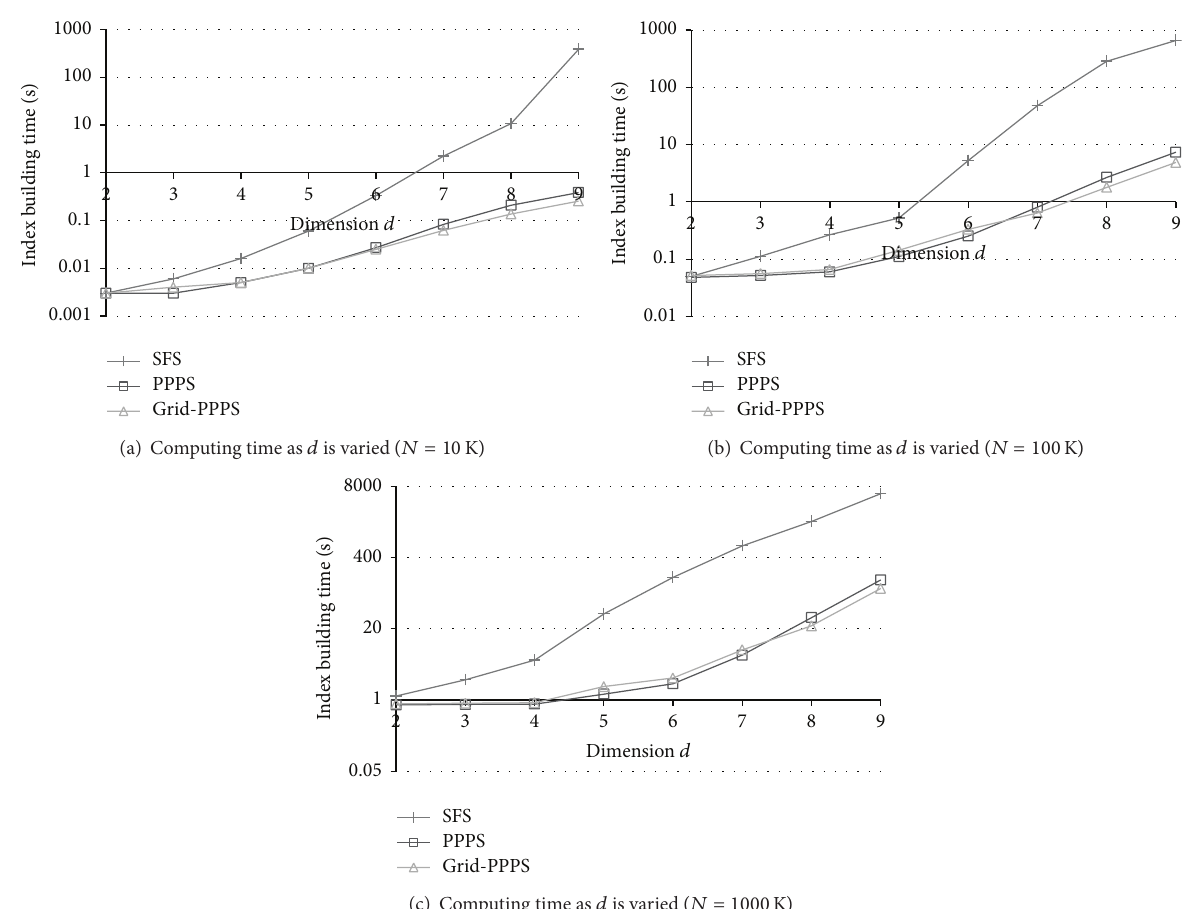
Figure 5: The comparison of the computing time of Grid-PPPS and SFS as 𝑑 and 𝑁 are varied related to Experiment 2.